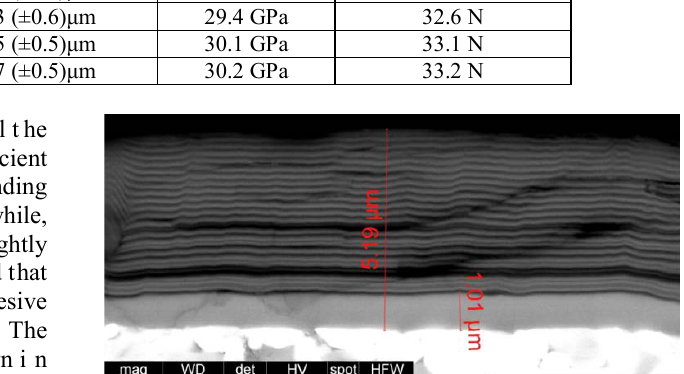
Table 1. Main parameters of the coatings under study. Type of coating Coating thickness Hardness TiAlN 4 (±0.8)μm 30.3GPa